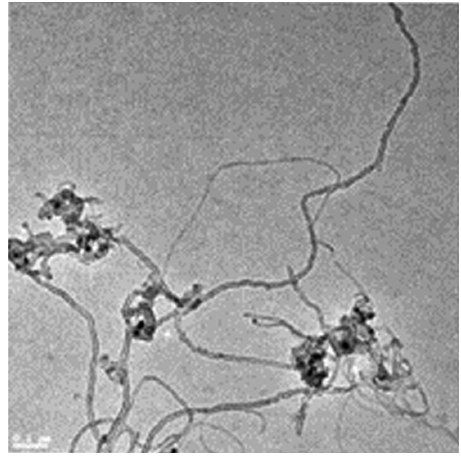
Figure 3 HR TEM image of the CNTs at 0.1 μ